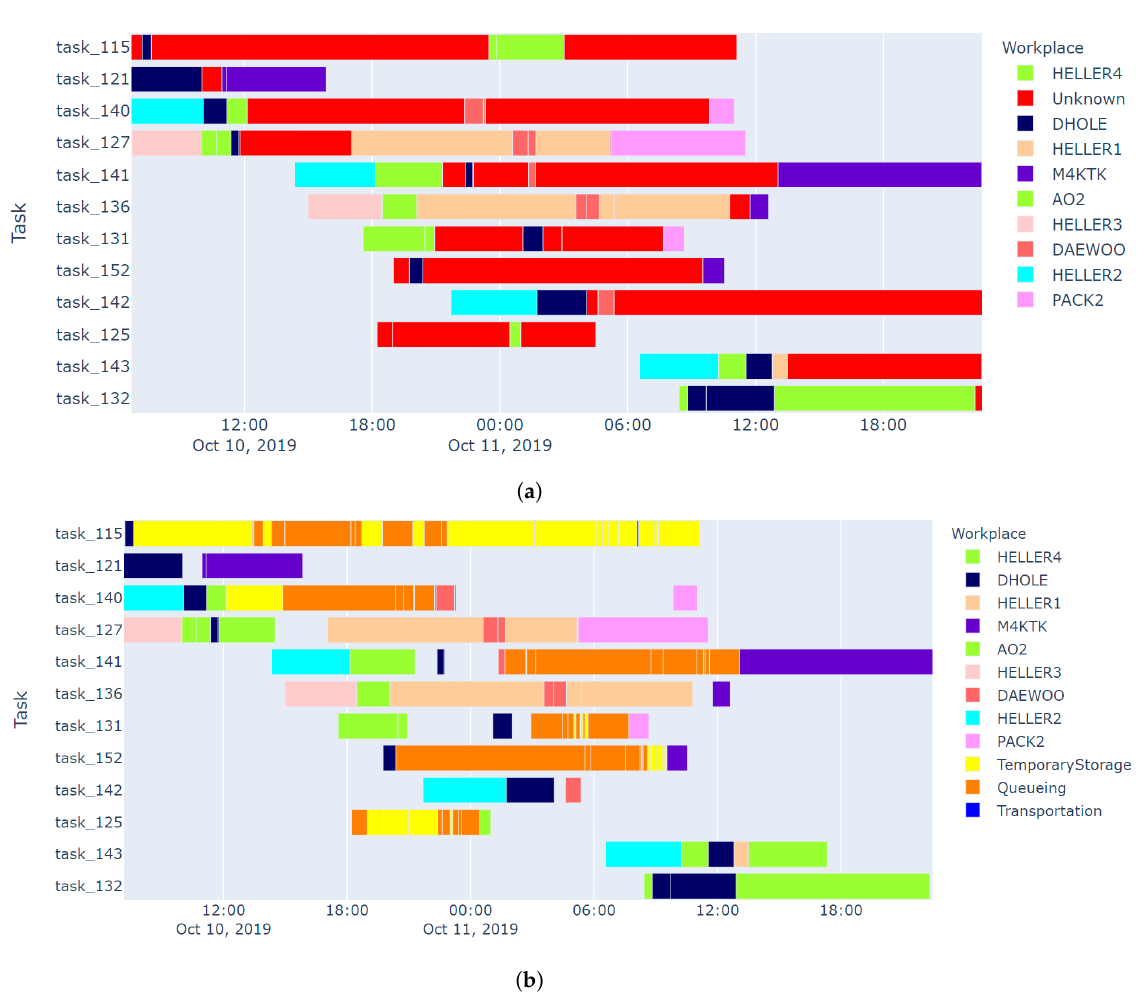
Figure 6. The Gantt diagrams show the states of the production of a given product. The comparison of the two diagrams shows the benefit of the additional information of the IPS. ( a ) Gantt diagram based on MES data. ( b ) Gantt diagram based on IPS and MES